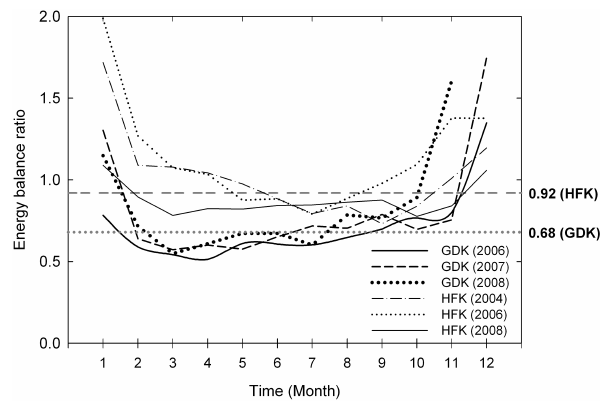
Fig. 2. Monthly Energy Balance Ratio (EBR) at the GDK site (2006 to 2008) and at the HFK site (2004, 2006, and 2008). The short- dotted line represents the annual average value for the GDK site, whereas the long-dotted line represents the annual average for the HFK